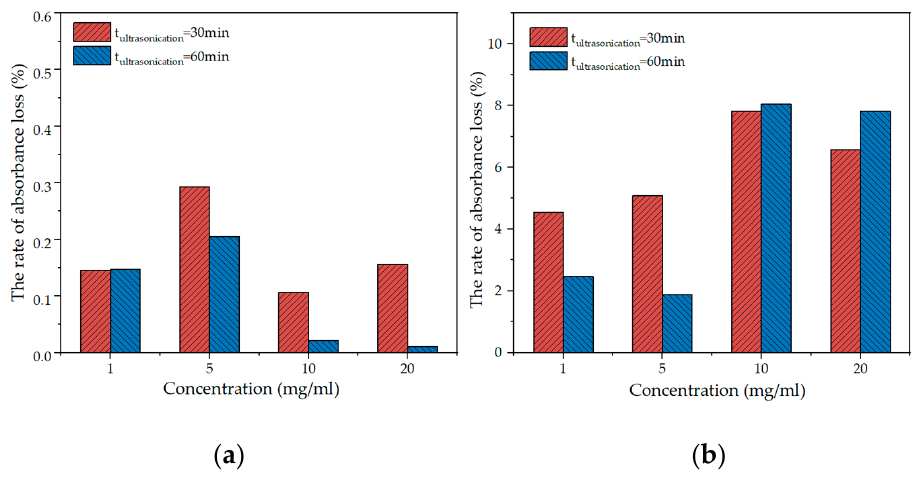
Figure 4. The rate of absorbance loss at different PVP concentrations after different days: ( a ) 3 d; ( b ) 120 d.